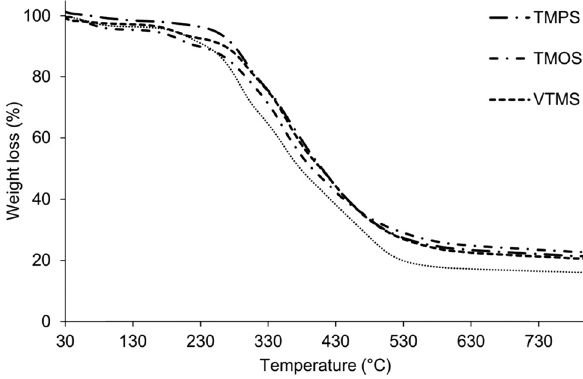
Figure 2: TGA without and with silane ( 163 ) . Copyright © 2019, Springer